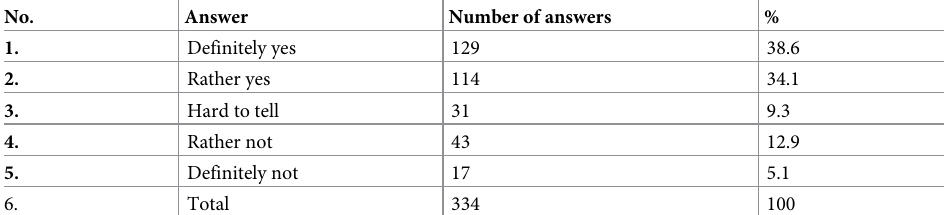
Table 13. The emotional dimension of the mother-scientist role conflict. Source: Study by Ewa Krause.